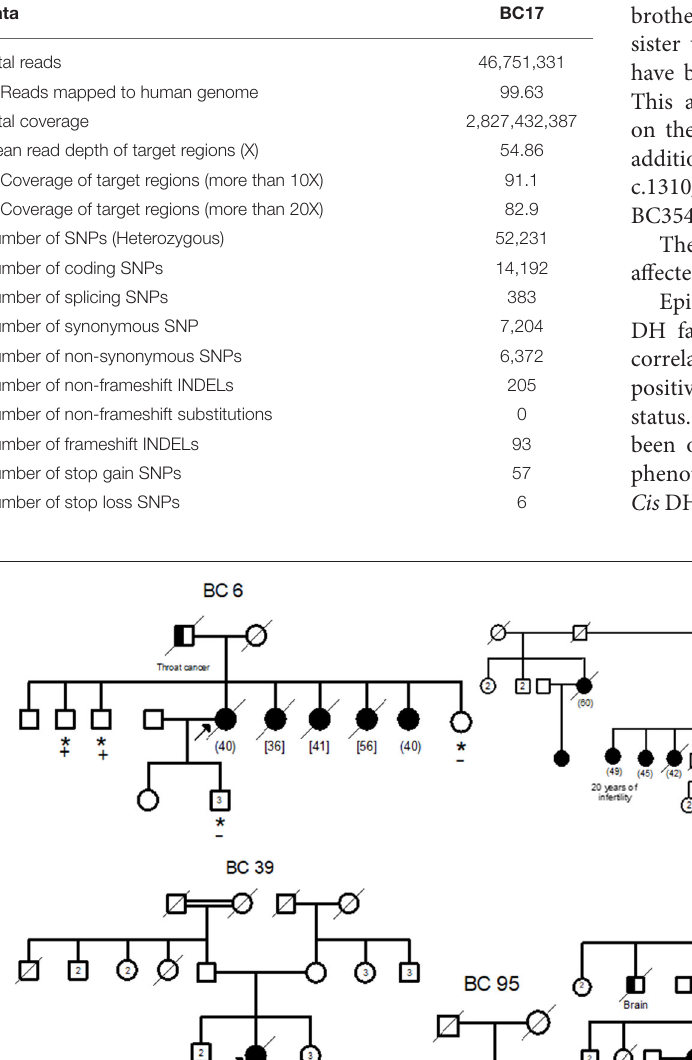
TABLE 1 | Exome sequencing data.